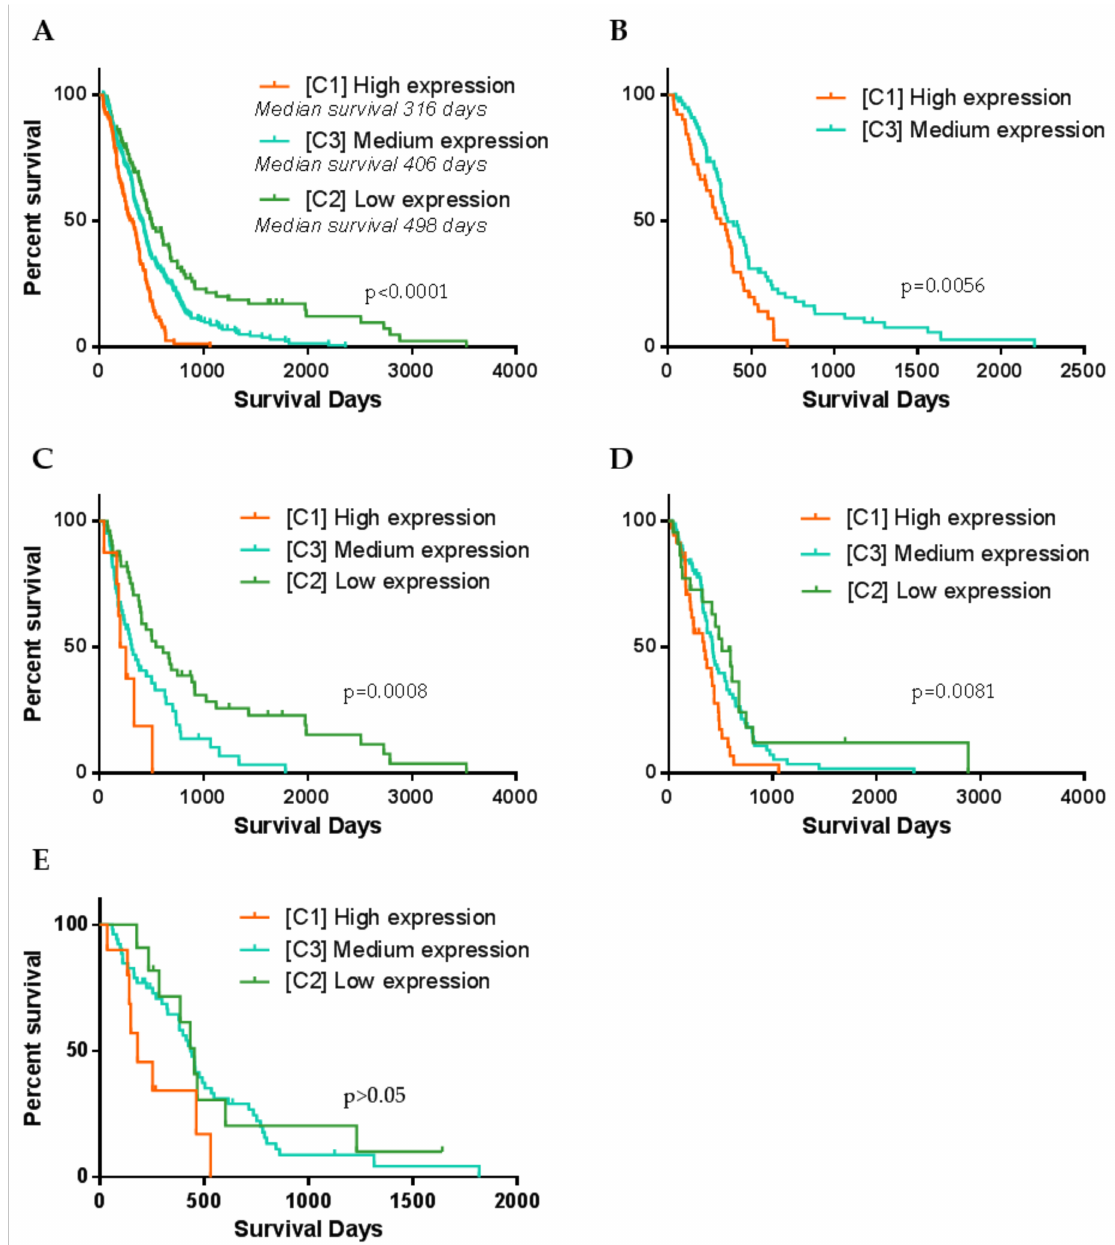
Figure 4. Kaplan–Meier curve plots representing different GBM patients’ groups survival. ( A ) Patient survival curves when specimens were divided according to the cluster dependence. ( B ) Only Mesenchymal GBM subtype patient survival curves calculated according to the cluster dependence. ( C – E ) Accordingly, Proneural, Classsical and Neural GBM subtype patient survival curves calculated according to the cluster dependence. p -value given based on Log-Rank (Mantel–Cox)